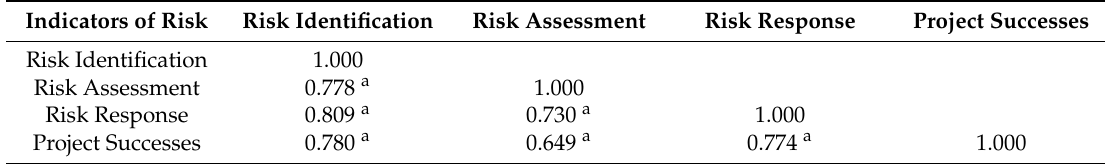
Table 7. Pearson Correlation between Effective Risk Management and Project